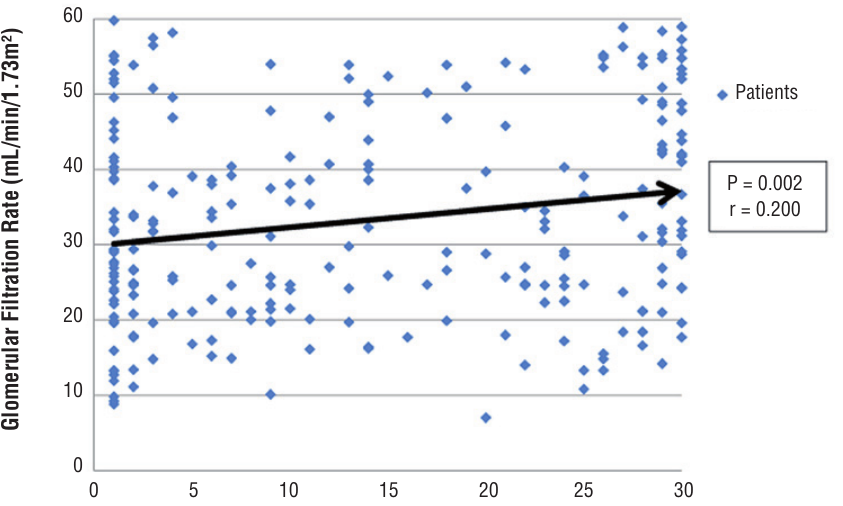
Figure 6 - Relationship of International Index of Erectile Function score and glomerular filtration rate. P =Statistical significance; r =Pearson correlation